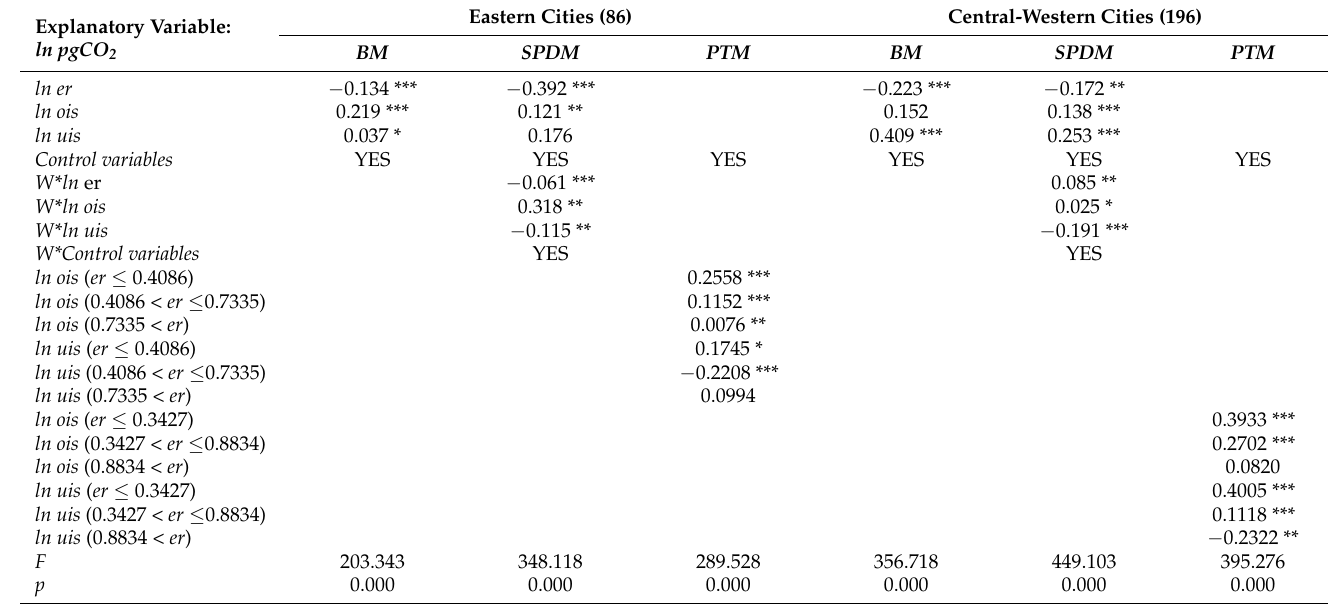
Table 8. Estimation results of the robustness test